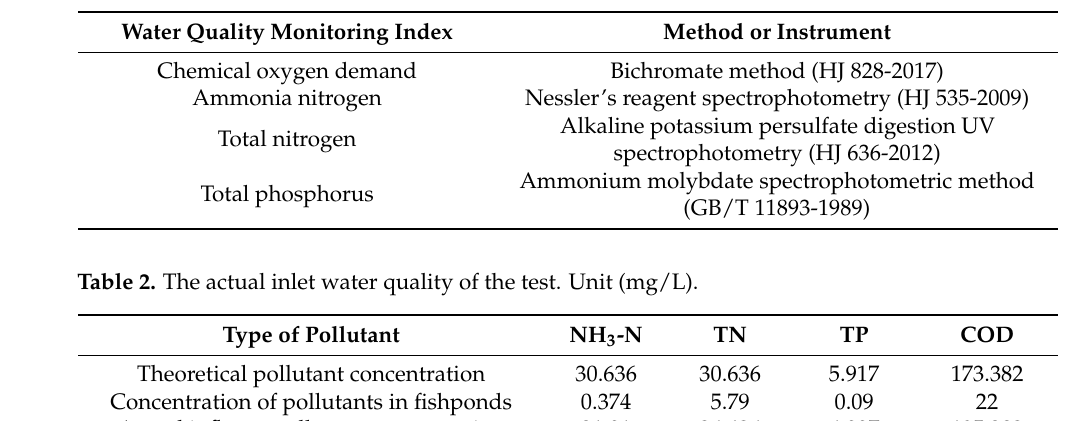
Figure 2. Biochar was added to the small particle size ceramsite layer ( a ); biochar was added to the zeolite layer ( b ); biochar was added to the small particle size ceramsite layer and the zeolite layer ( c ). Table 1. The monitoring indexes and methods of water quality.